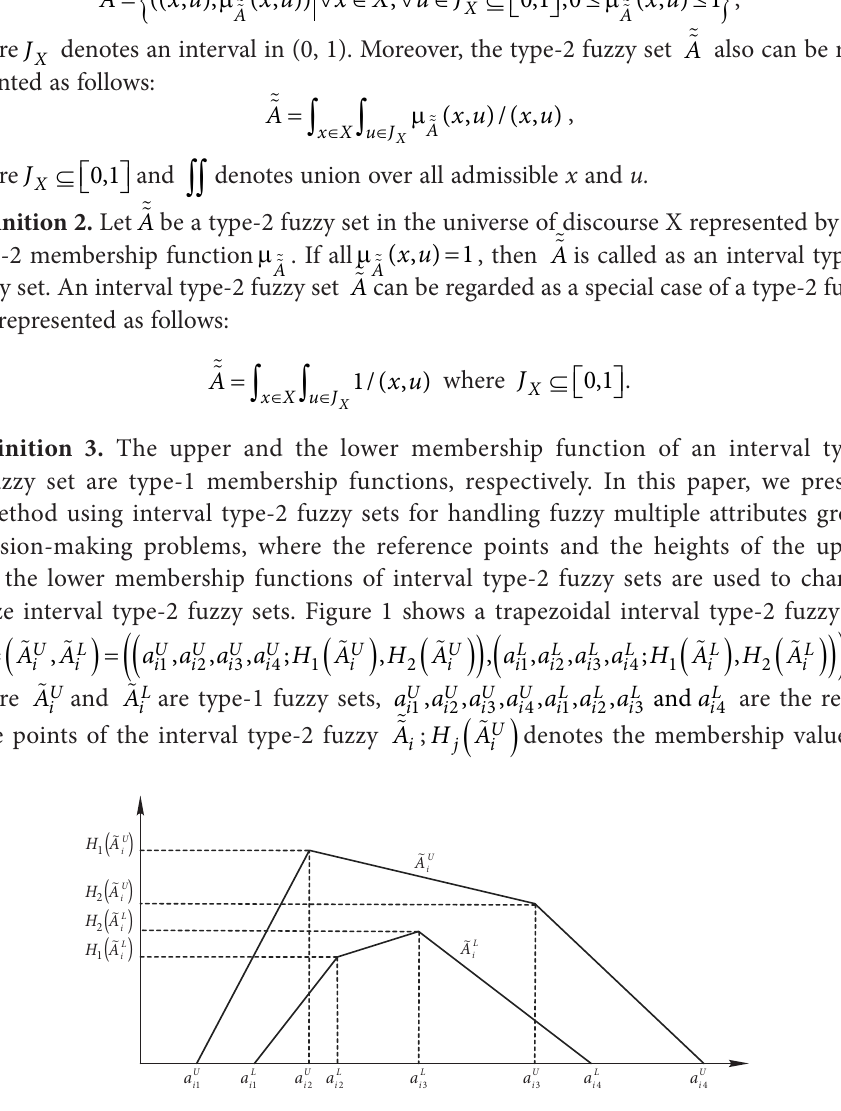
Fig. 1. The trapezoidal interval type-2 fuzzy sets membership